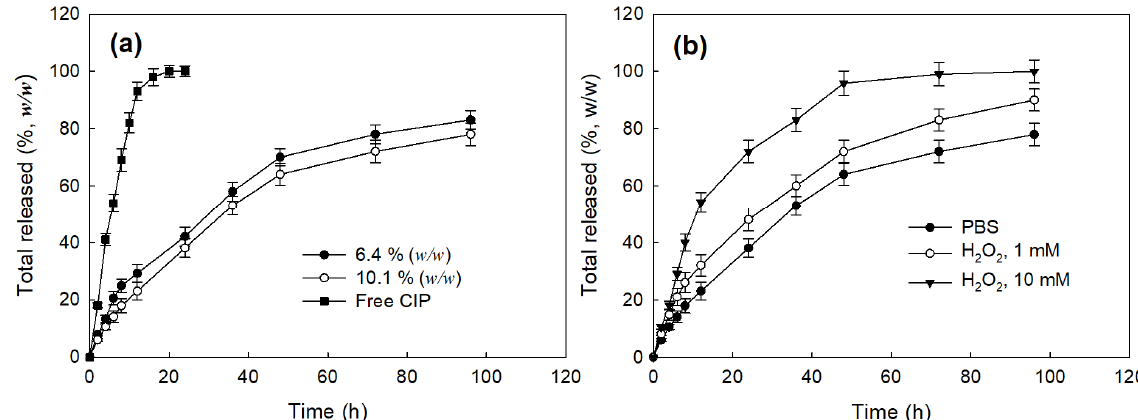
Figure 4. Drug release behavior of CIP-incorporated LGseseTAPEG nanoparticles. ( a ) The effect of drug contents and ( b ) the addition of H 2 O 2 in the drug release media. To test the effect of H 2 O 2 , CIP-incorporated nanoparticles (10.1% ( w / w )) was reconstituted into PBS in the presence or absence of H 2 O 2 . To assess the effect of H 2 O 2 addition, CIP-incorporated nanoparticles (drug content: 10.1% ( w / w )) were used.